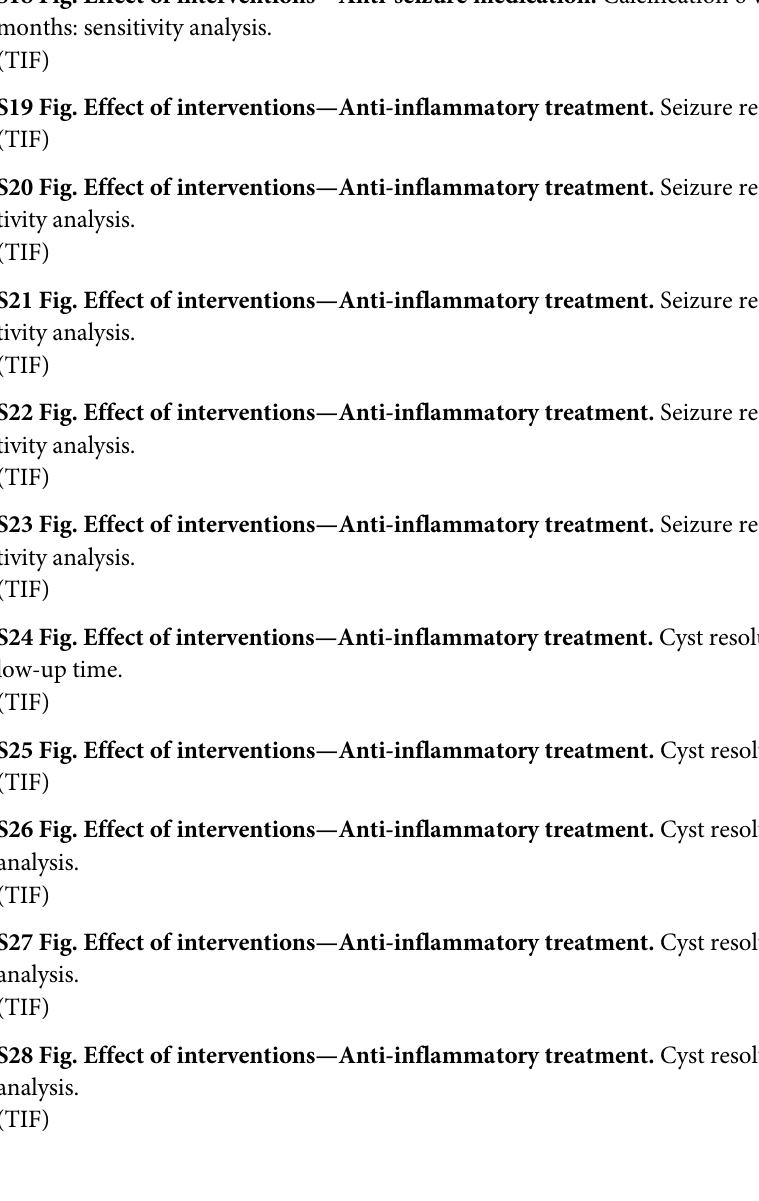
S14 Fig. Effect of interventions—Anti-seizure medication. Cyst resolution 6 versus 24 months: sensitivity analysis. (TIF) S15 Fig. Effect of interventions—Anti-seizure medication. Calcification 6 versus 12–24 months. (TIF) S16 Fig. Effect of interventions—Anti-seizure medication. Calcification 6 versus 12–24 months: sensitivity analysis. (TIF) S17 Fig. Effect of interventions—Anti-seizure medication. Calcification 6 versus 12–24 months: sensitivity analysis. (TIF) S18 Fig. Effect of interventions—Anti-seizure medication. Calcification 6 versus 12–24 months: sensitivity analysis. (TIF) S19 Fig. Effect of interventions—Anti-inflammatory treatment. Seizure recurrence (TIF) S20 Fig. Effect of interventions—Anti-inflammatory treatment. Seizure recurrence: sensi- tivity analysis. (TIF) S21 Fig. Effect of interventions—Anti-inflammatory treatment. Seizure recurrence: sensi- tivity analysis. (TIF) S22 Fig. Effect of interventions—Anti-inflammatory treatment. Seizure recurrence: sensi- tivity analysis. (TIF) S23 Fig. Effect of interventions—Anti-inflammatory treatment. Seizure recurrence: sensi- tivity analysis. (TIF) S24 Fig. Effect of interventions—Anti-inflammatory treatment. Cyst resolution -shorter fol- low-up time. (TIF) S25 Fig. Effect of interventions—Anti-inflammatory treatment. Cyst resolution. (TIF) S26 Fig. Effect of interventions—Anti-inflammatory treatment. Cyst resolution: sensitivity analysis. (TIF) S27 Fig. Effect of interventions—Anti-inflammatory treatment. Cyst resolution: sensitivity analysis. (TIF) S28 Fig. Effect of interventions—Anti-inflammatory treatment. Cyst resolution: sensitivity analysis.